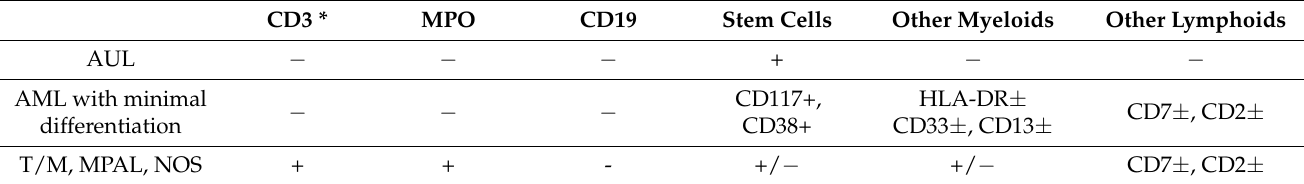
Table 1. Immunophenotypic features of immature leukemias.